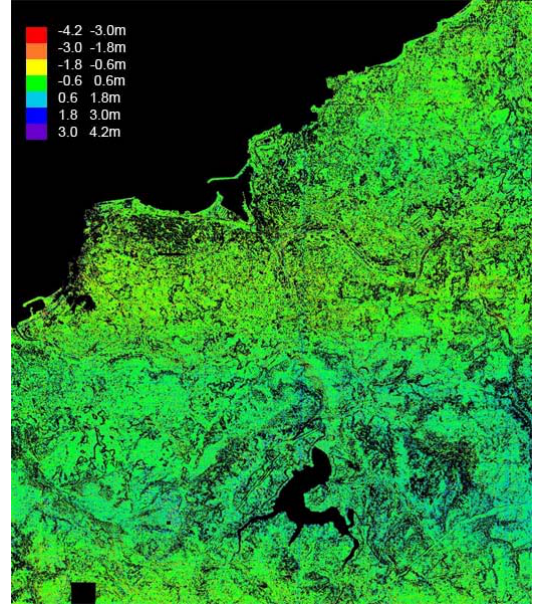
Figure 14 . Colour coded height differences of the filtered DSM FL against CF Figure 14 with the colour coded height differences of the filtered DSM based on the combination of first and last image against the DSM based on the centre and first image shows only small height differences, but indicates with the green-blue tone in the elevated parts a small scale difference of the heights. The analysis shows a small, but significant height scale difference of 0.13%. The incidence angle for the combination of the centre and the first image of 6° is sensitive for small deviations of the direct sensor orientation which only has been improved in the horizontal plane by bias